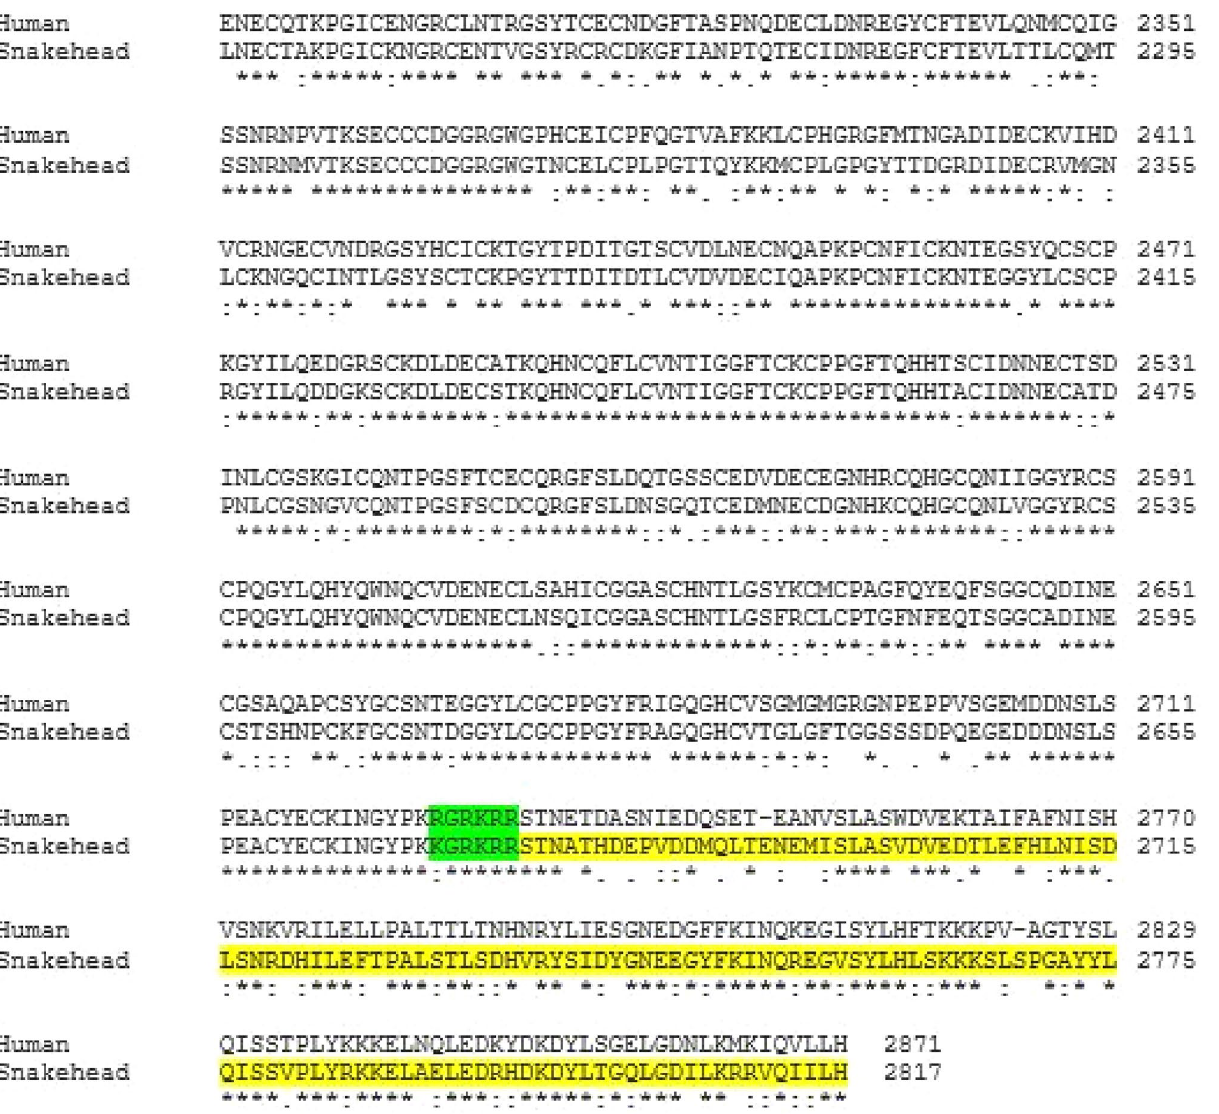
(Table 1). The percent identity matrix of the primary sequence of putative asprosin of C. punctata with asprosin of H. sapiens revealed 57.86% similarity. The post-translational modifications such as N-linked glycosylation and phosphorylation were predicted using Motif scan software (Fig. 4). Two conserved N-linked glycosylation sites at position 3 and 37 were predicted in ss asprosin. Phosphorylation sites at 5, 16, 42, 56, 88 and 89 positions were predicted in asprosin of C. punctata .